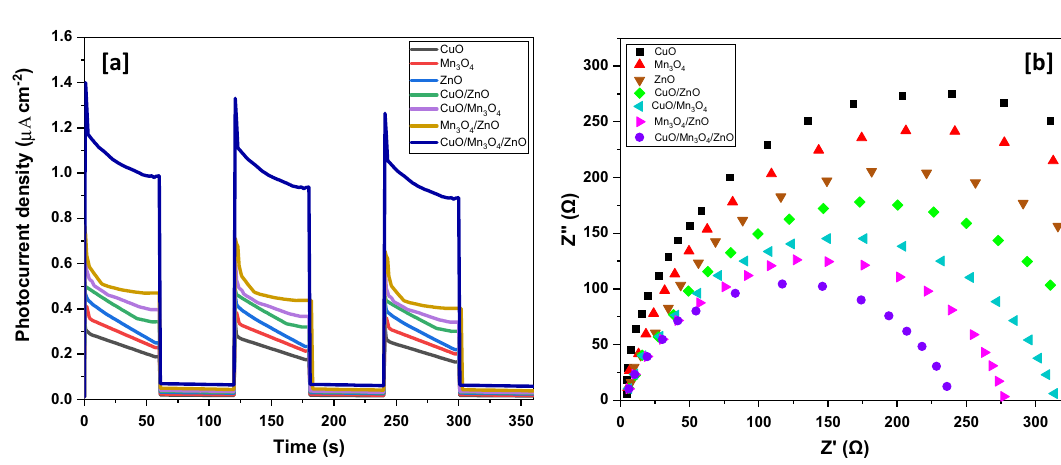
Figure 13. ( a ) Transient photocurrent and ( b ) EIS of various